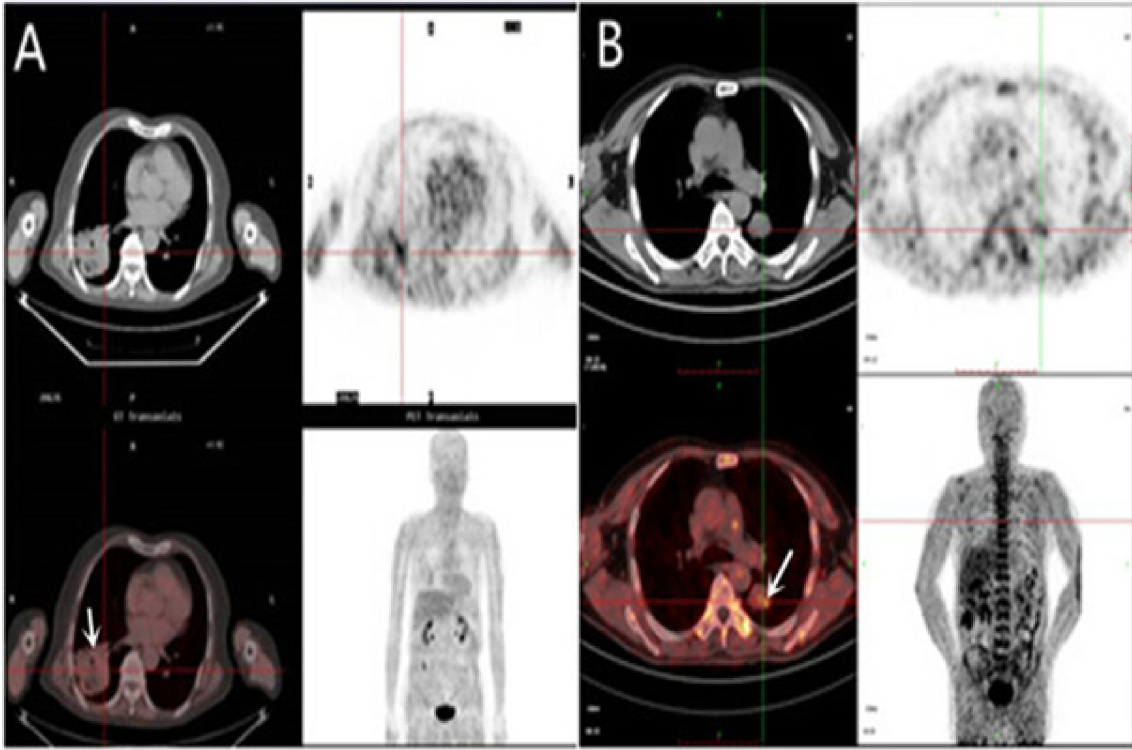
Fig 1. PET imaging. Major organs and regions uptake at 2 h after injection of 18 F-FETNIM ( A ) in squamous carcinoma patient and 18 F-FMISO ( B ) in small cell lung cancer patient. Arrows point to